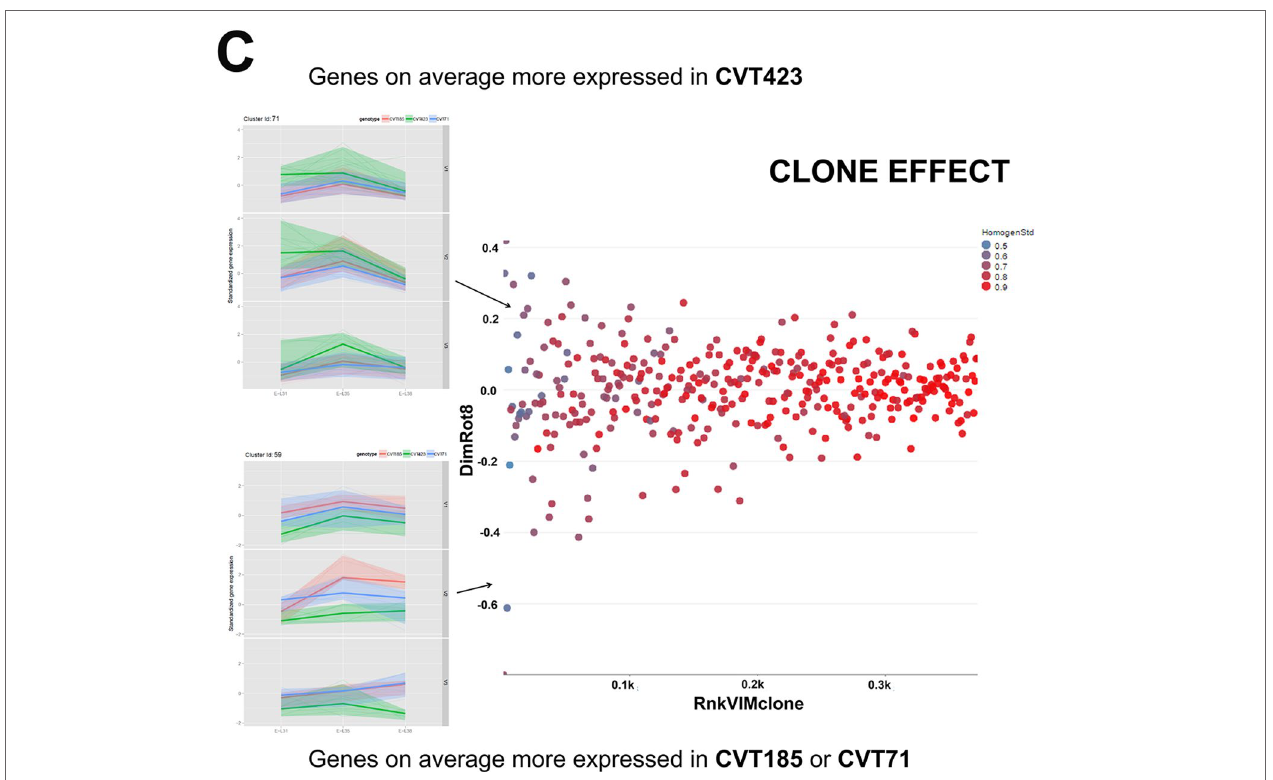
FIGURE 2 | Schematic illustration of the effect exerted by (A) Stage, (B) Environment, or (C) Clone on gene cluster expression. Scatterplots of the 112 clusters were displayed according to the rank in (A) VIM Stage, (B) VIM Vineyard, and (C) VIM Clone (e.g., Rnk_VIM_Stage = rank of clusters according to VIM Stage; low values denote high importance of the stage) and to the loading in the specific rotated principal component (DimRot) (first, fifth, and eighth components for stage, vineyard and clone, respectively). Each dot represents a single cluster. Dots were colored according to the cluster homogeneity index reported on the right at the top of each scatter plot. Examples of clusters are provided within each scatter plot. A complete list of the 112 clusters is reported in Table S6 .